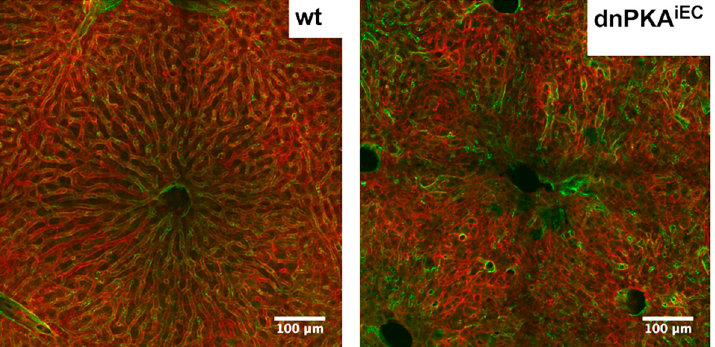
Figure 9. Disorganization of the hepatic vasculature in dnPKA iEC mice. Representative liver slices of control (Tg(Cdh5-cre/ERT2)1Rha carrying mT/mG transgene) and dnPKA iEC mice carrying the mT/mG reporter are shown. Endothelial cells are green due to expression of GFP, non-endothelial cells are red due to expression of dTomato. Scale bar, 100 µm.